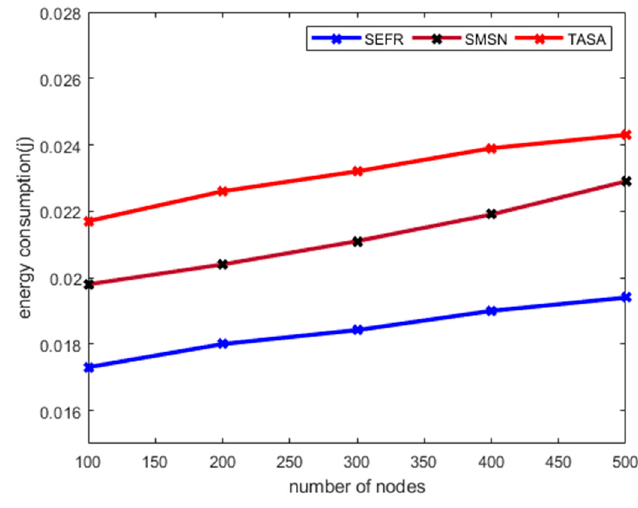
Figure 2. Energy consumption with a varying number of nodes.